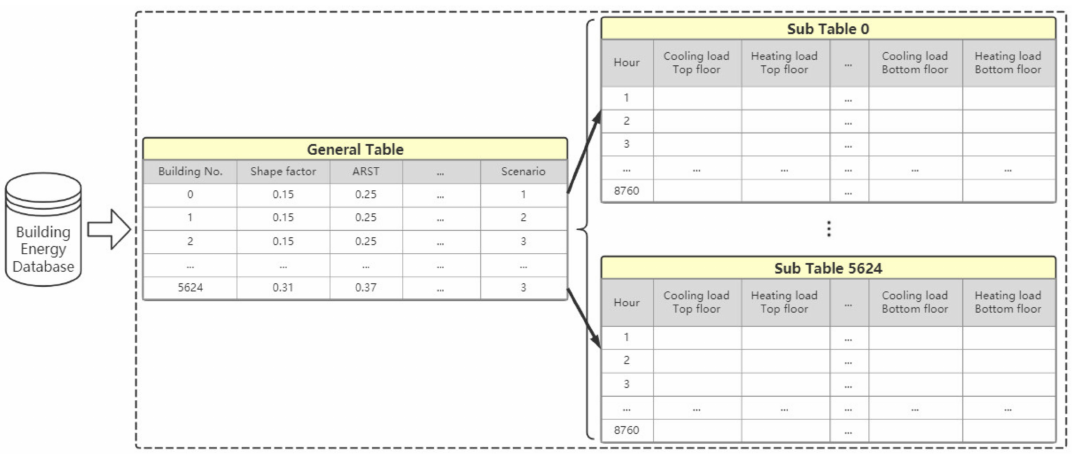
Figure 10. Structure of the presimulated model